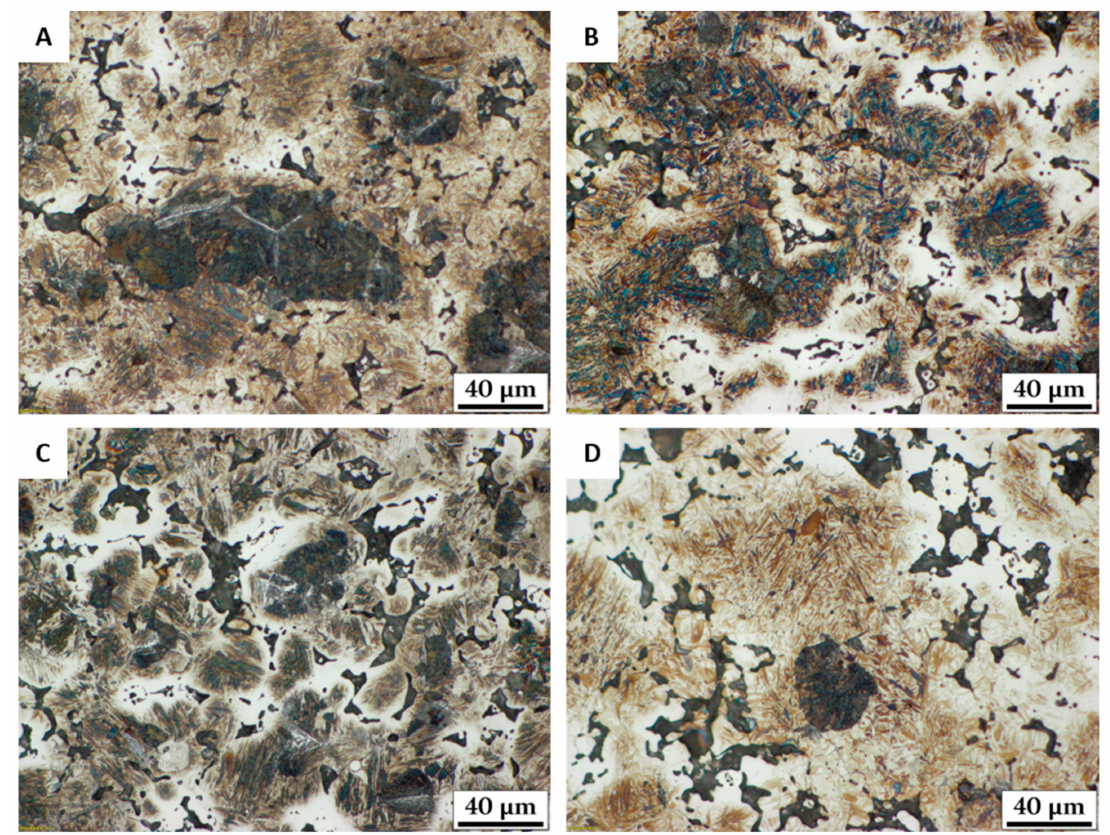
Figure 7. Metallographic sections of samples heated at 10 K/min to 1180 ◦ C in the quenching dilatometer and then immediately quenched as fast as possible (~22.5 K/s). (A) ASC + 4%CrMA1_0.6C, (B) ASC + 4%CrMA1_0.75C, (C) ASC